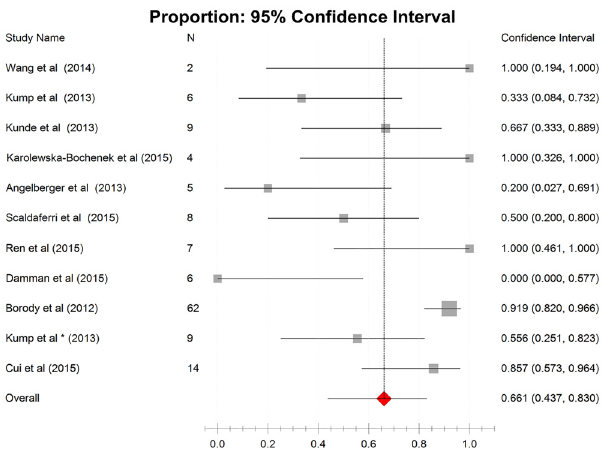
Fig 3. Forest plot of all cohort studies in clinical response. Pooled estimate of 66.1% (95% CI 43.7%-